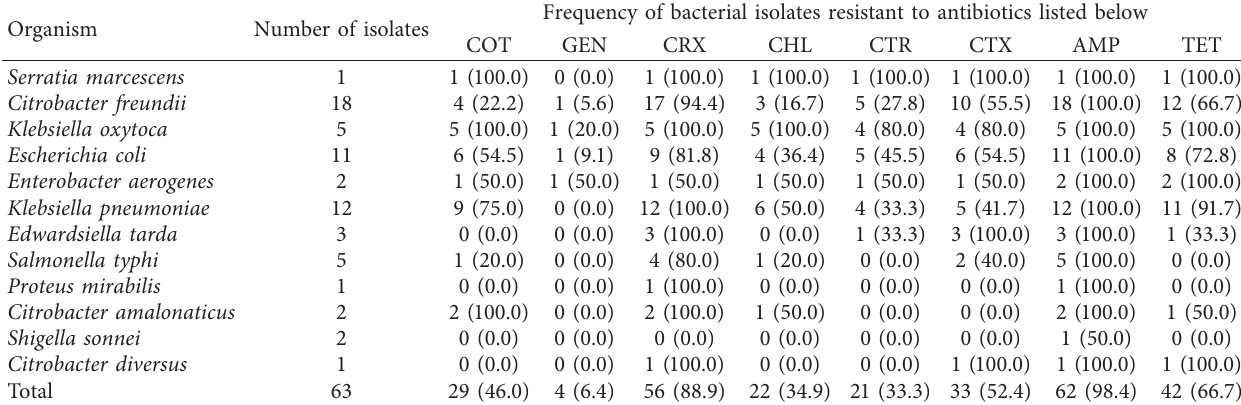
Table 2: Distribution of 63 bacterial isolates and their antibiogram (percentage in brackets).